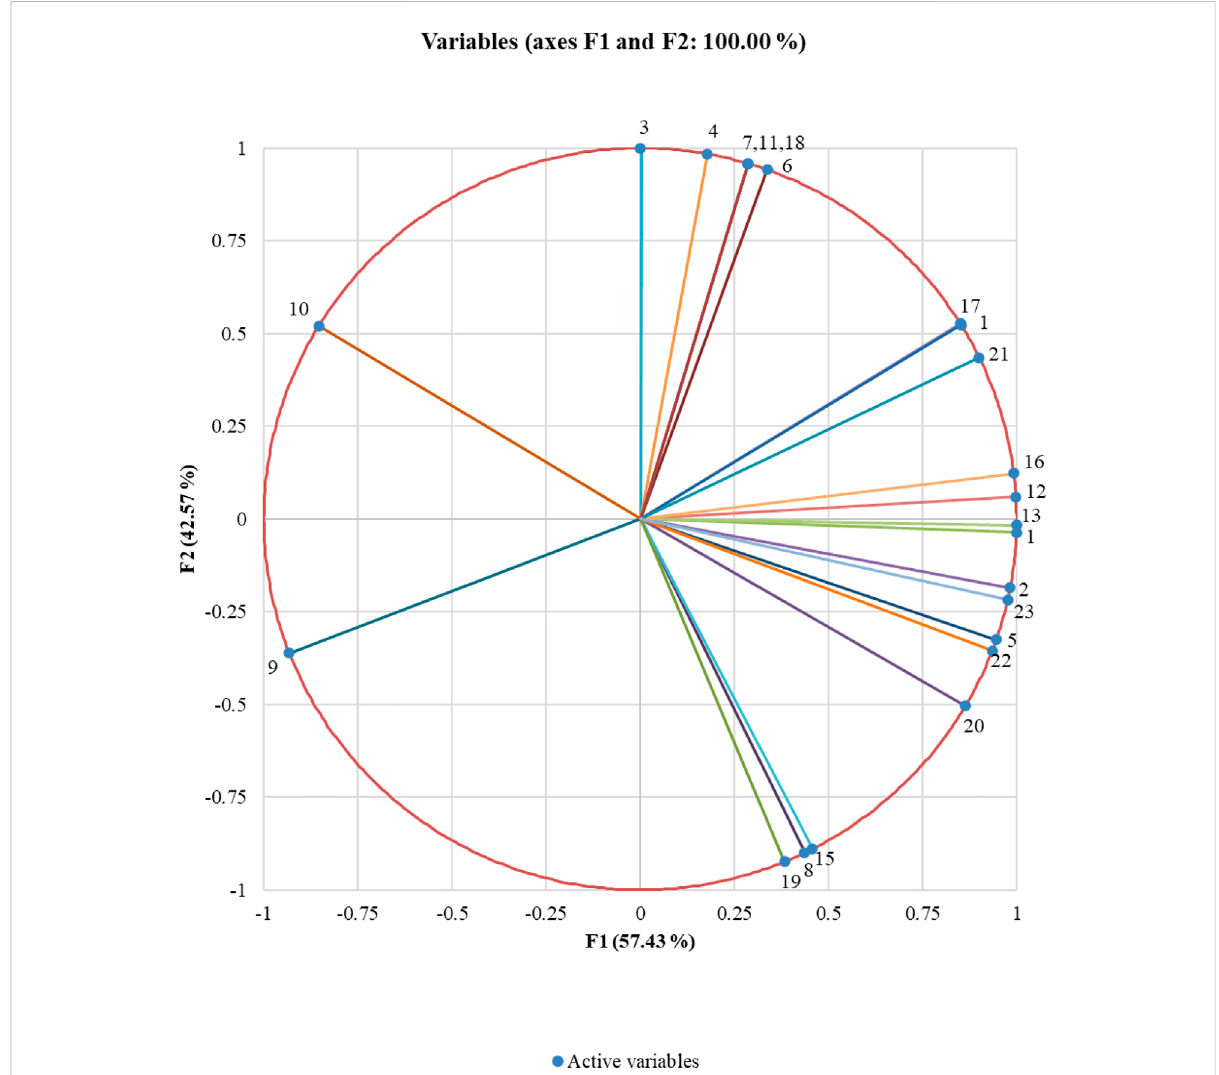
FIGURE 4 Correlation circle showing the association between volatile compounds. Data points are the mean of three replicates. The closely placed volatilecompoundsarepositivelycorrelatedtoeachotherwhereasorthogonal placesarenotcorrelated;andiftheyareontheoppositeside,thenit shows a negative correlation with each other. From the correlation circle, it is clear that all the variables are far away from the centre suggesting the ability of the extracted principal components to explain the variables. It is thus clear that the volatiles (E)-2-hexen-1-ol and caryophyllene are negatively correlated to each other, whereas those closely placed together like (+)- α -pinene and (+)-sylvestrene are positively correlated, and the ones like 1-methyl-cyclopentanol and ( − )- β -pinene are not correlated (Supplementary Table